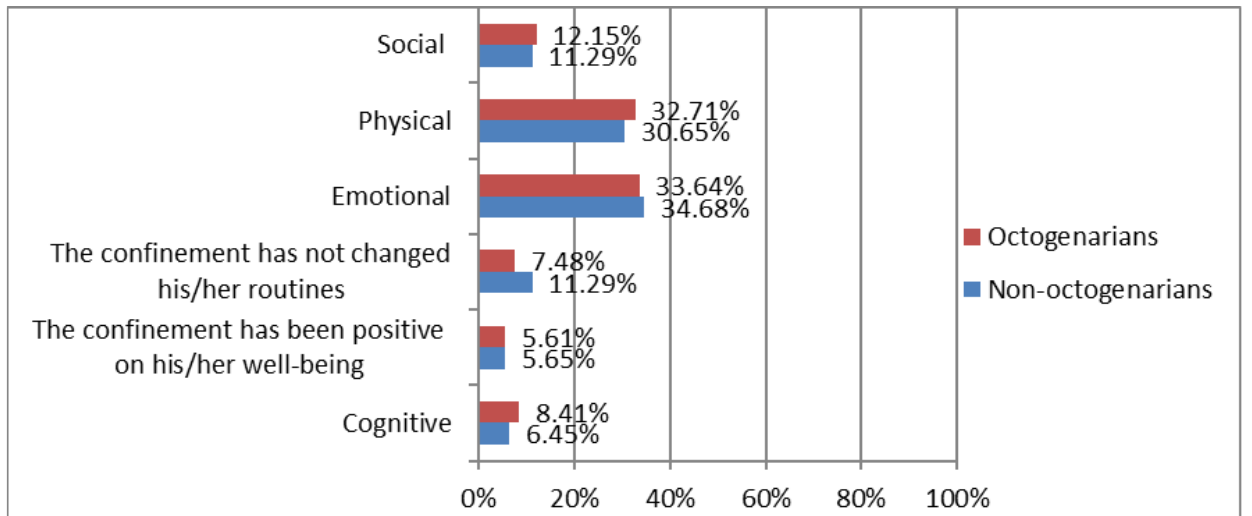
Figure 1. Differences between octogenarians vs. non-octogenarians in alterations in well-being caused by COVID-19 confinement. Octogenarians ( ≥ 80 years; n = 53). Non-octogenarians (<80 years; n = 67).